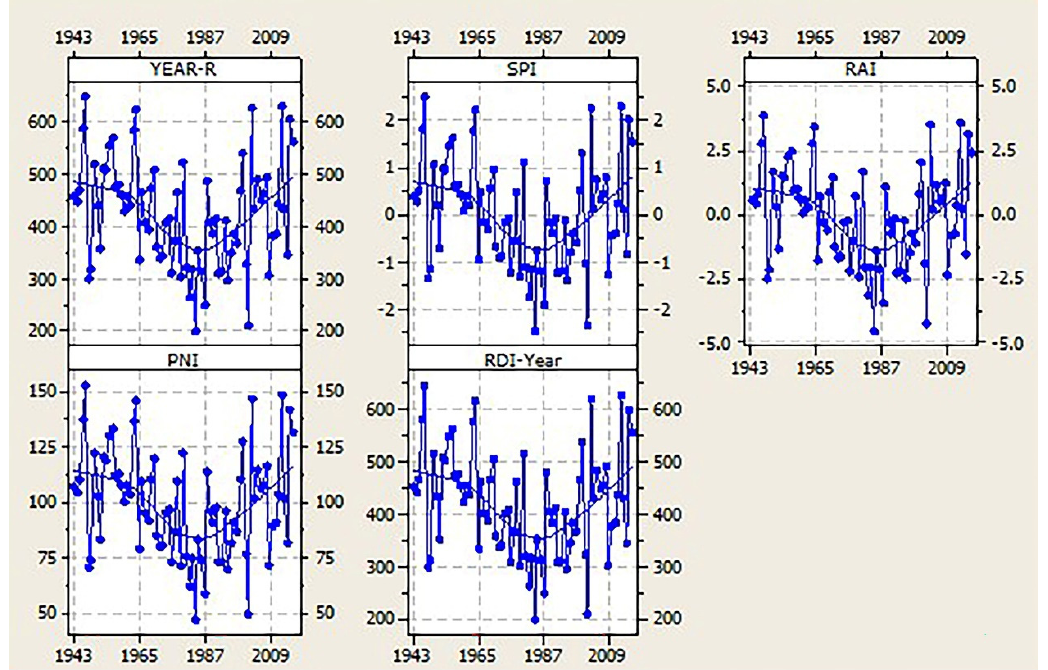
Figure 5. Annual time series plots of observed rainfall, RDI, SPI, PNI, and RAI.